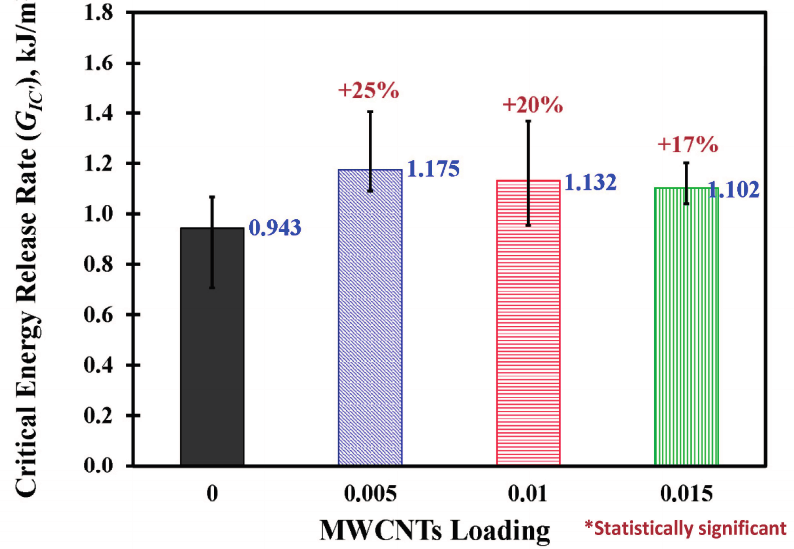
Figure 11. A comparison of the maximum critical energy release rates for the four MWCNTs content specimens. Maximum G IC values are shown on graph. Percentages shown above bars represent the difference (improvement) compared with the neat